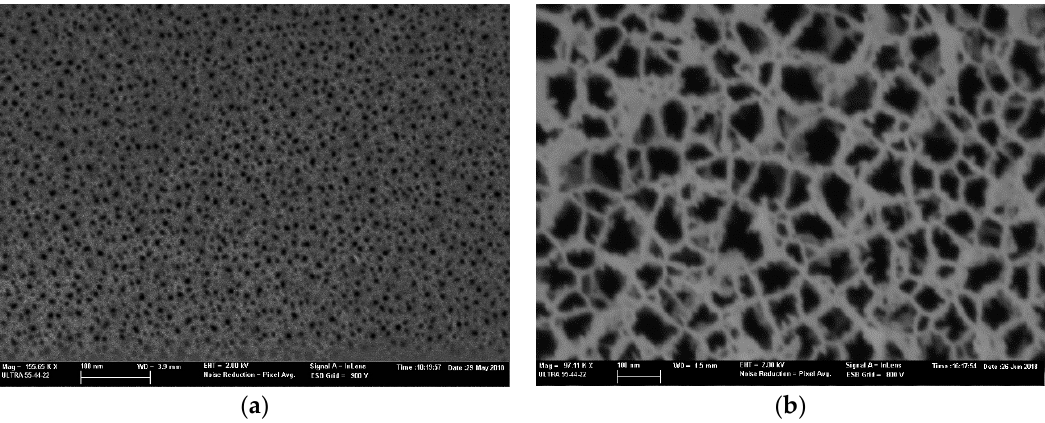
Figure 2. FESEM images of electrochemically etched p-type Si 0.001–0.005 Ω∙ cm ( a ) HF:EtOH 2:1, I =